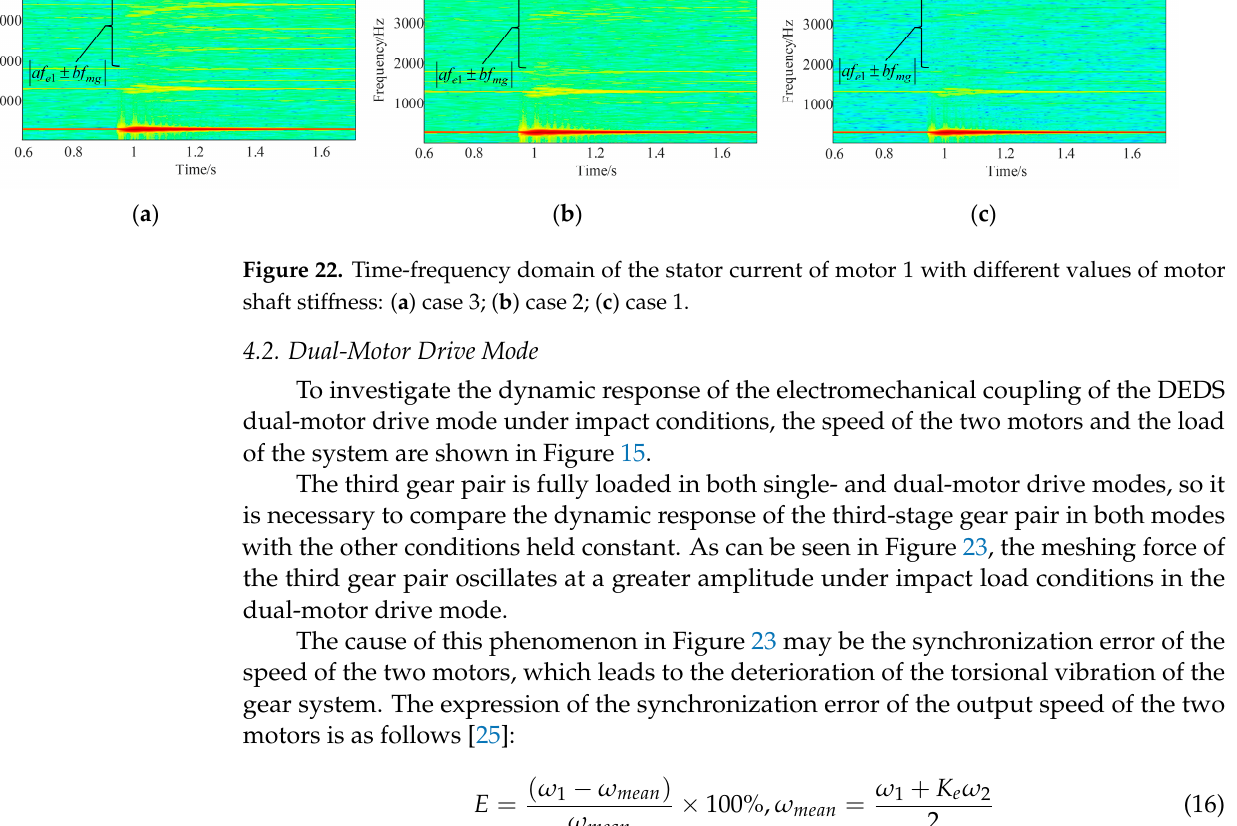
Figure 23. The meshing force of the third gear pair.